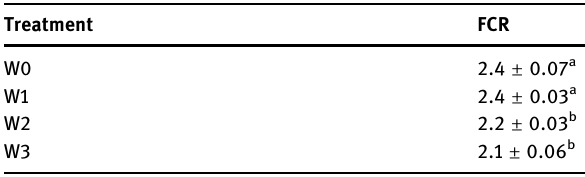
Table 4: Feed conversion rate of native chicken during 8 weeks